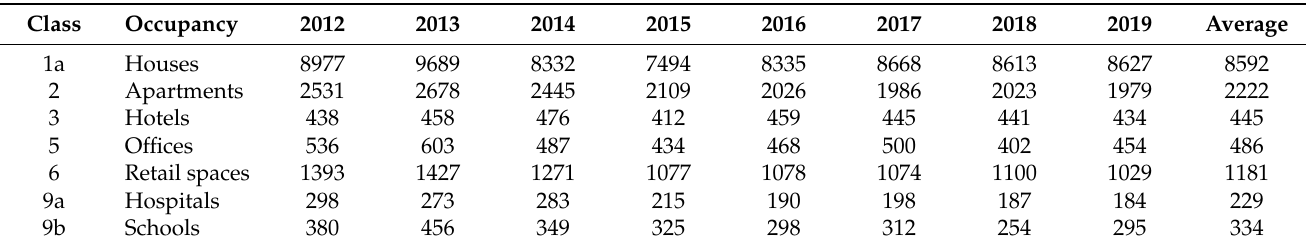
Table 2. Structural fire incidents for NCC Classes in Australia from 2012 to 2019 [fires/year] extracted from [20].